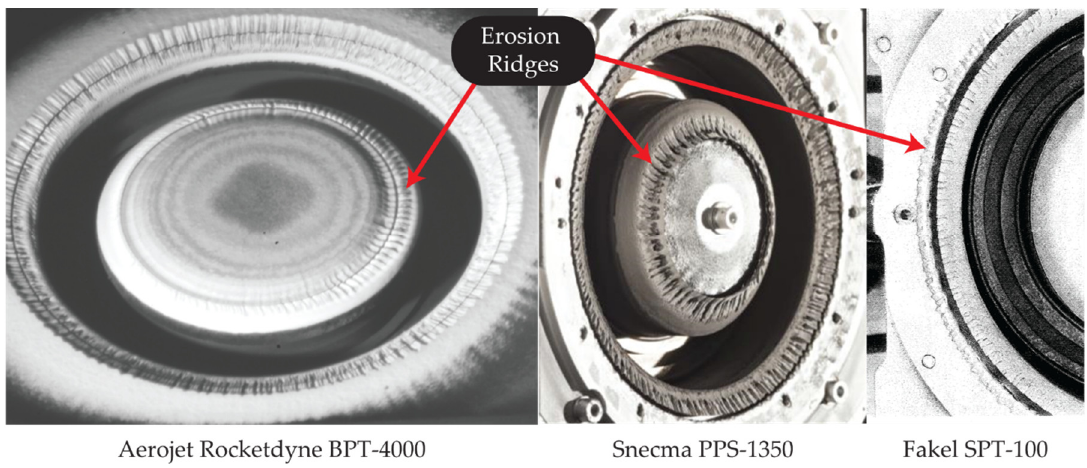
Figure 6. Erosion ridges in the Aerojet Rocketdyne BPT-4000, Snecma PPS-1350, and Fakel SPT-100 walls. Images reprinted with permission from [18], Aerojet Rocketdyne, 2010; with permission from [66], Snecma, 2019; and with permission from [15], American Institute of Aeronautics and Astronautics, 1995.